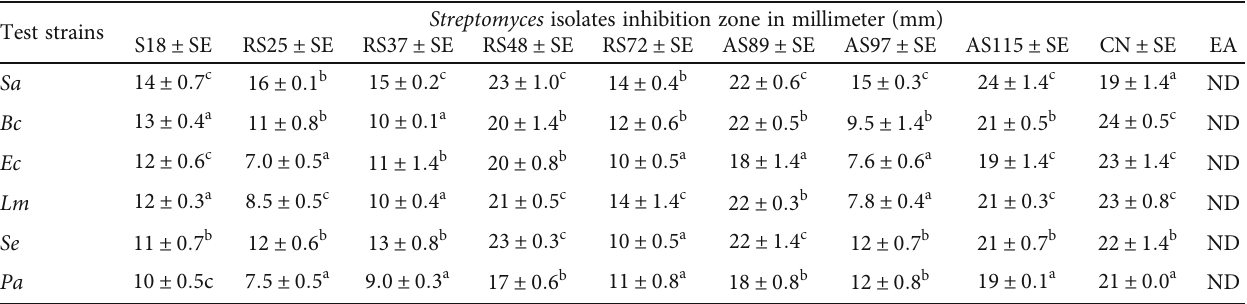
Table 3: Secondary screening of Streptomyces isolates in triplicate mean ± SE of the clear zone in mm against spoilage and foodborne bacterial pathogens using the disc di ff usion